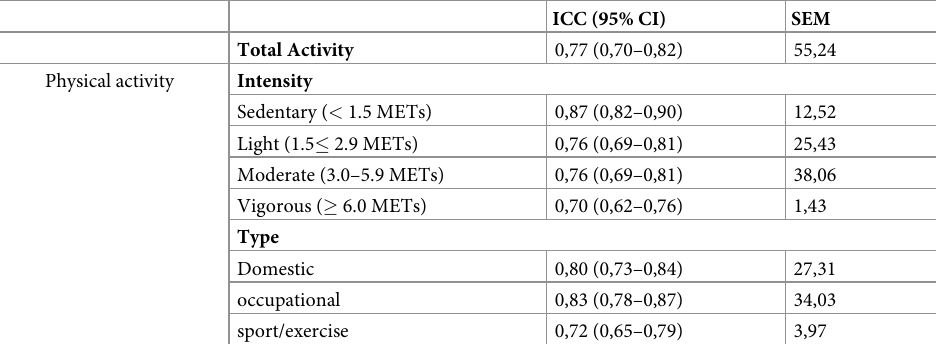
Table 4. Intraclass Correlation Coefficient (ICC) and Standard Error of Measurement (SEM) between PPAQ1 and PPAQ2 (n = 184).